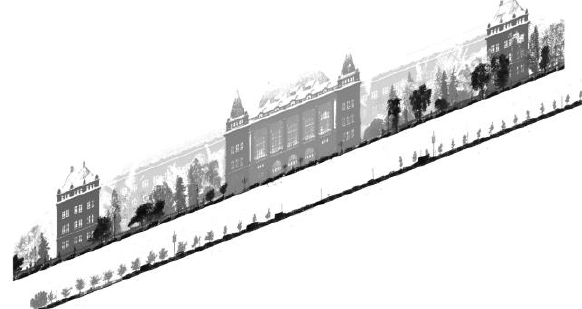
Figure 8. A “street view”-like visualization of both